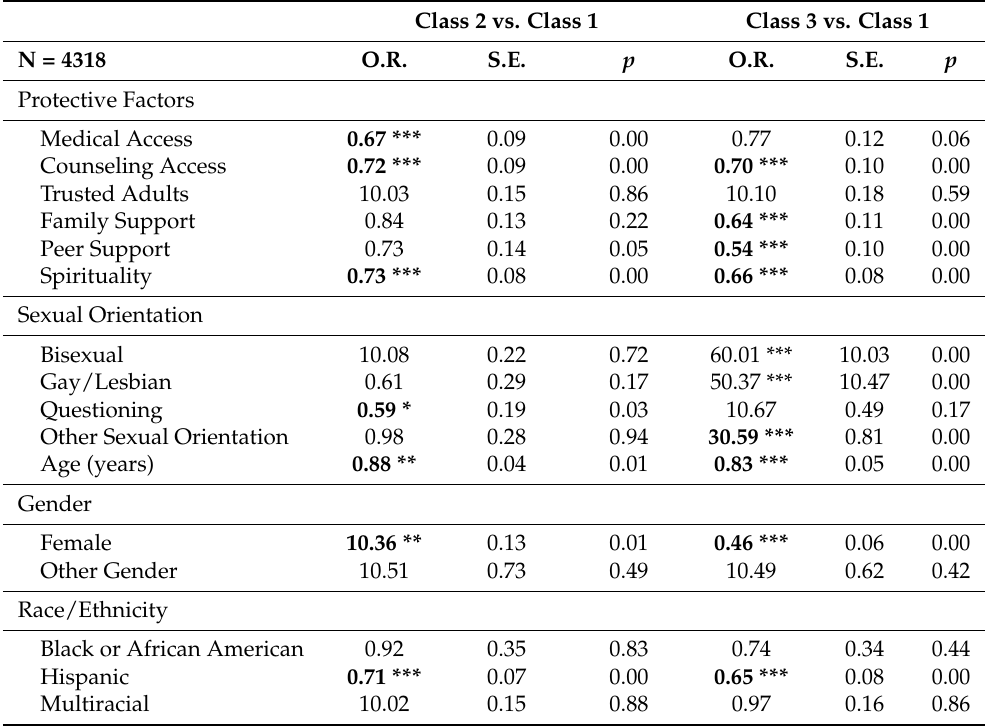
Table 7. Latent Class Multinomial Logistic Regression of the Likelihood of Class Membership with Class 1 as the Reference